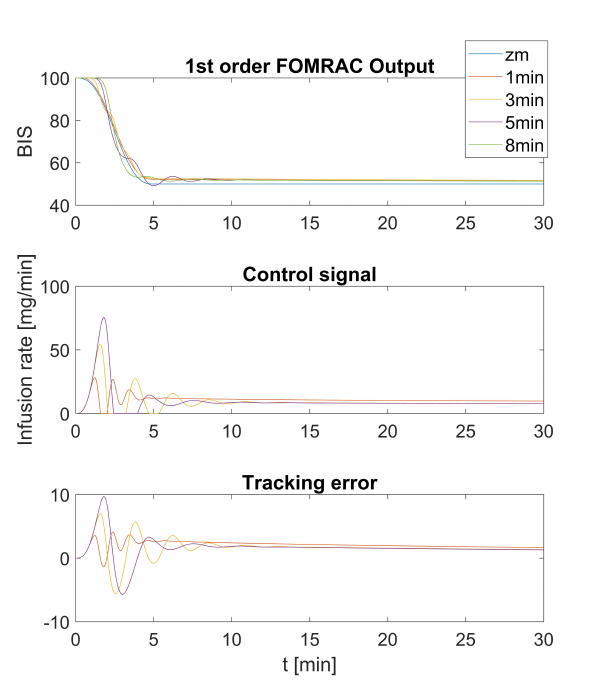
Figure 21. BIS response of patient 1 with different time delays using the 1st-order FOMRAC scheme.